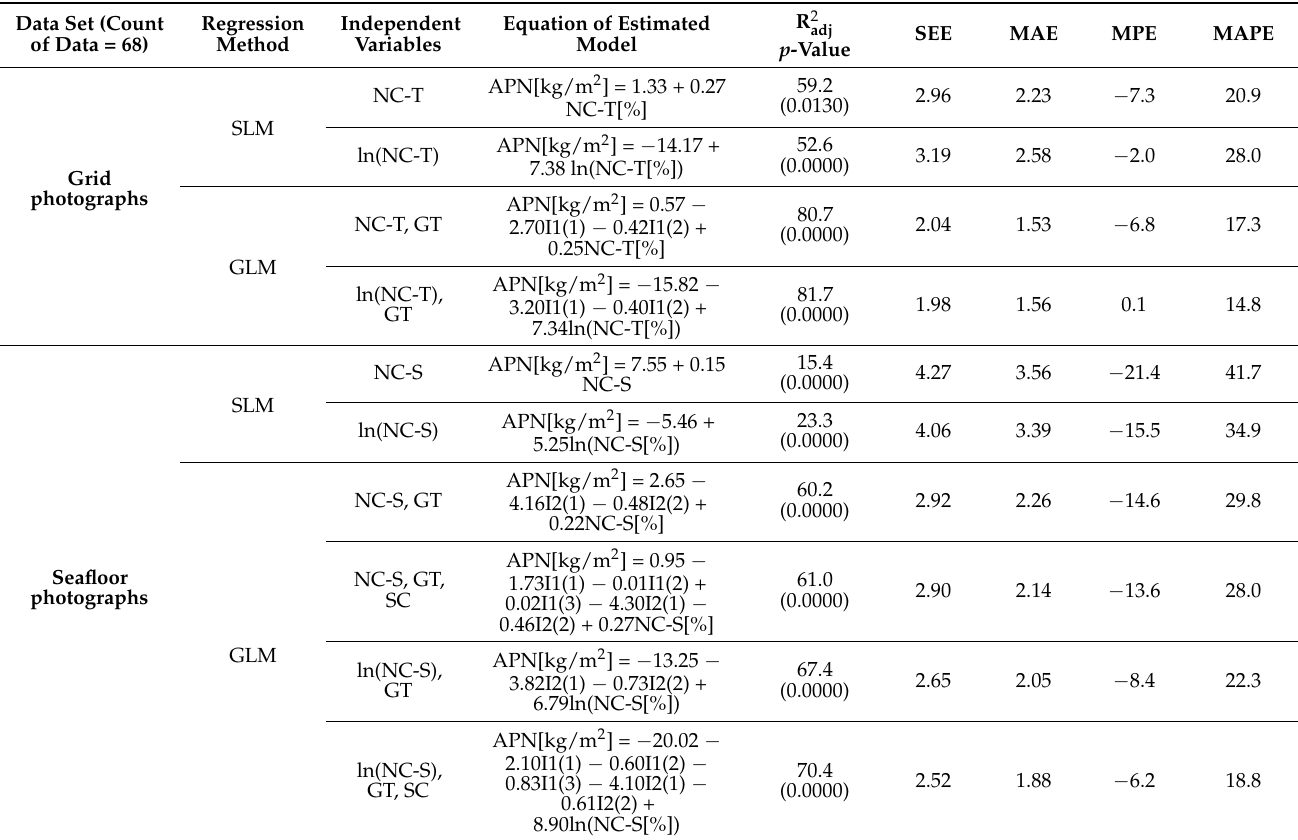
Table 3. Regression models between nodule abundance (APN) and seafloor nodule coverage (NC-S) or grid nodule coverage (NC-T) supported by the categorical variables: level of sediment coverage of nodules (SC) and genetic type of nodules (GT) based on photographs (count of data =